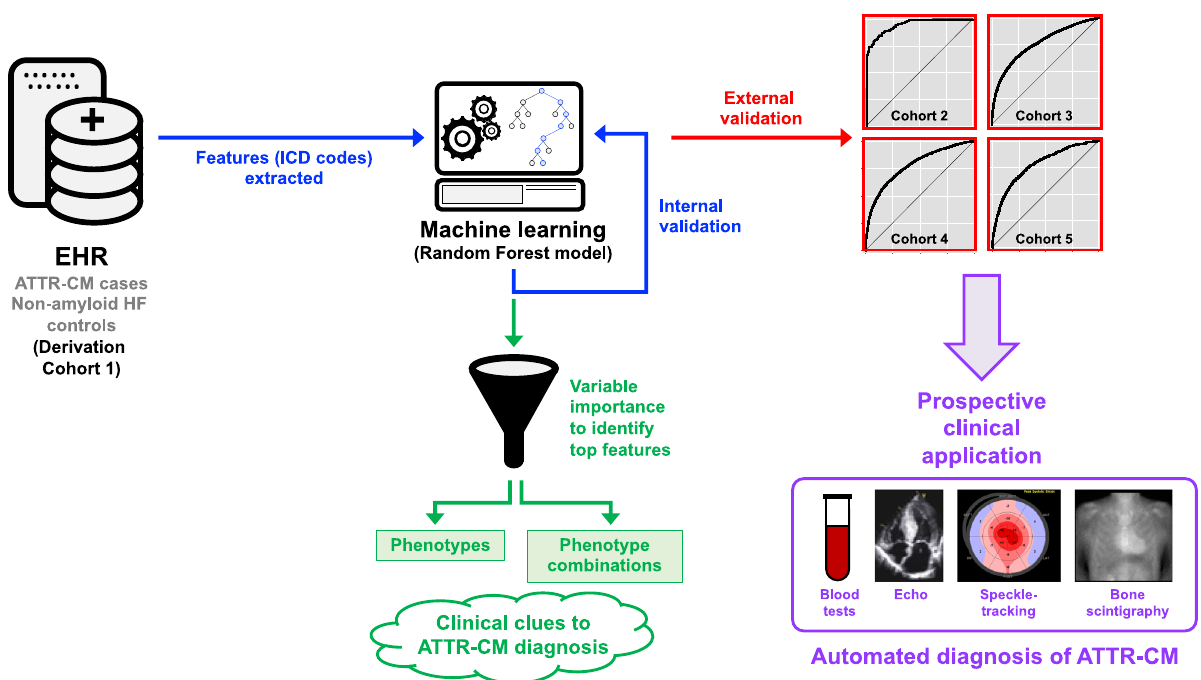
Fig. 4 Development and validation of a machine learning model of medical claims data for the systematic identi fi cation of wild-type transthyretin amyloid cardiomyopathy. Nationally representative medical claims data were used to develop a cohort of ATTR-CM and non-amyloid HF controls. ICD codes were extracted and used as features to train a Random Forest machine learning model, which was then internally tested in the derivation cohort. The model was then validated in four external cohorts, one of which was a single health system that is similar to how the model would be used in the clinical setting. The top features (ICD codes) based on variable importance in the Random Forest model were also used to generate phenotypes and phenotype combinations associated with the ATTR-CM diagnosis, which provide clinical insight and clues into the diagnosis. In the future, additional prospective clinical validation with blood tests, echocardiography (with speckle-tracking strain analysis), and bone scintigraphy can be used to verify the ATTR-CM diagnosis with the ultimate goal to automate the identi fi cation of ATTR-CM, thereby leading to earlier diagnosis and intervention of these high-risk patients. ATTR-CM, amyloidogenic transthyretin